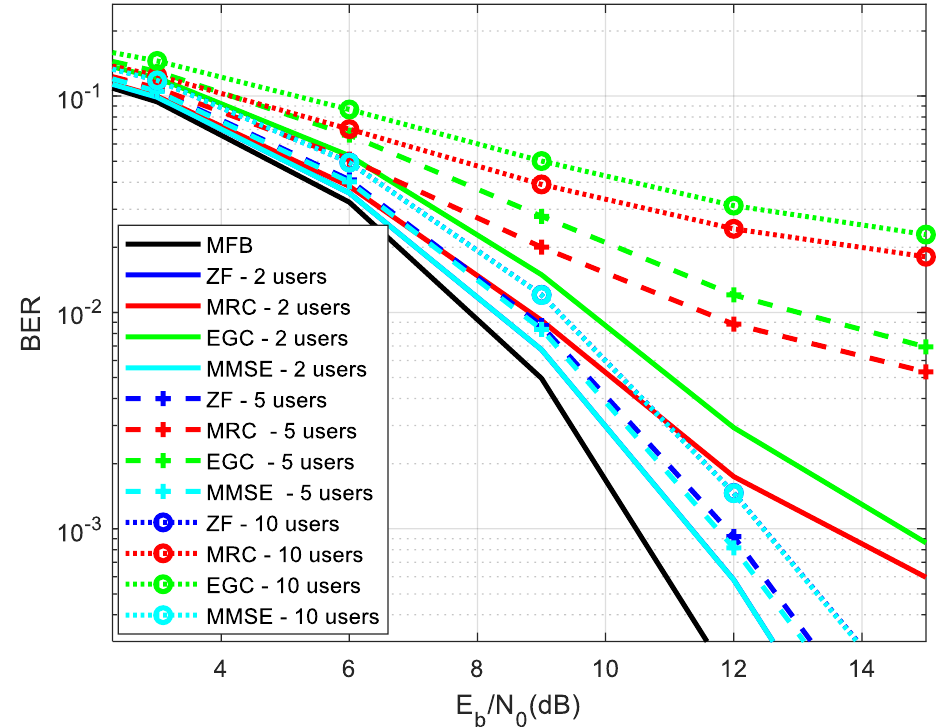
Figure 7. Results for 4X25 LIS System, with 2, 5, and 10 users, without LDPC codes.